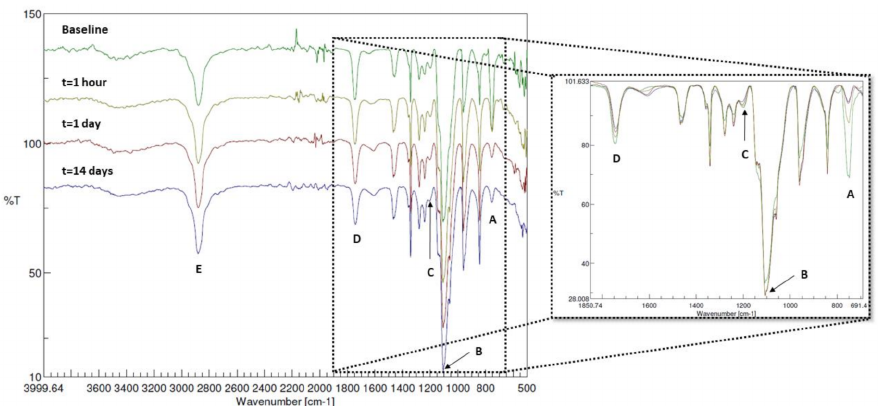
Figure 2. FT-IR spectra of the collected polymer prior to (baseline, t = 0, green) and after immersion in PBS for 1 h (yellow), 1 day (red) and 14 days (purple), with a zoomed in overlayed spectrum between 1850 and 700cm − 1 . The letters correspond to the different characterizations of the PEG or PLA, whereby (A): C=O (bend) backbone of PLA; (B): C-O-C (stretch) of PEG; (C): ester bonds (stretch) between LA units in PLA blocks and PLA-PEG; (D): C=O (stretch) of PLA; (E): C-H (stretch) from both PLA and PEG.